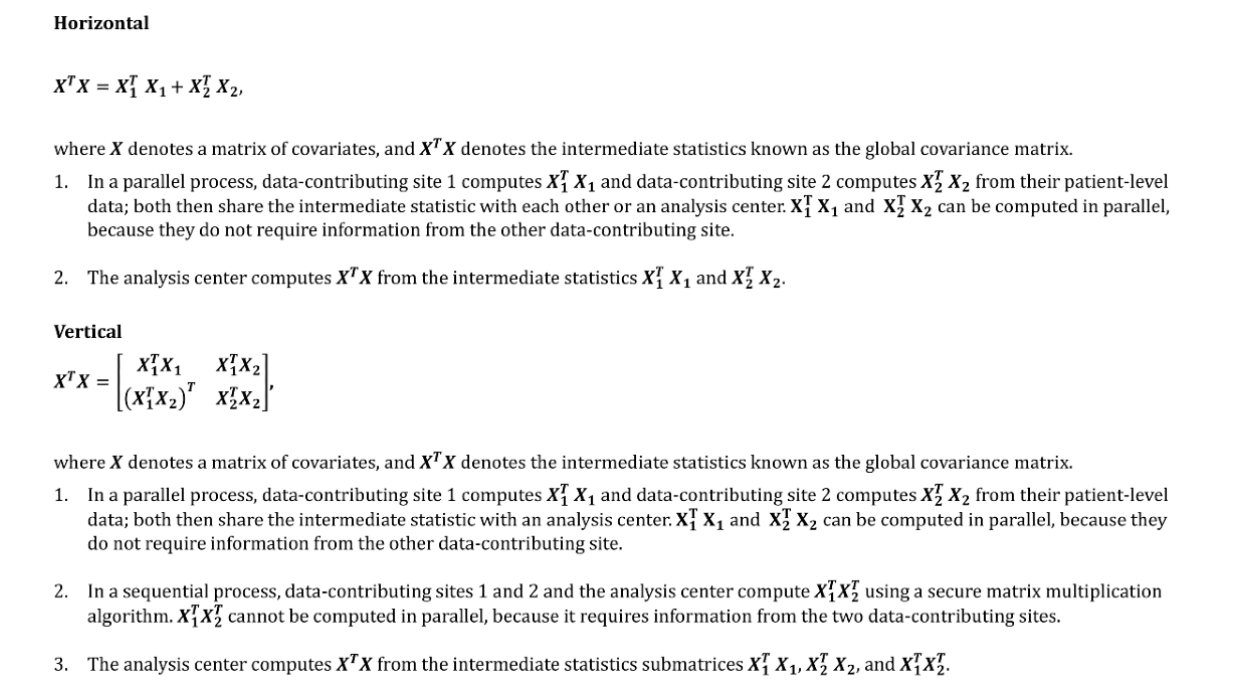
Figure 4. Processes required to perform distributed linear regression in horizontally or vertically partitioned data environments with two data-contributing sites and an analysis